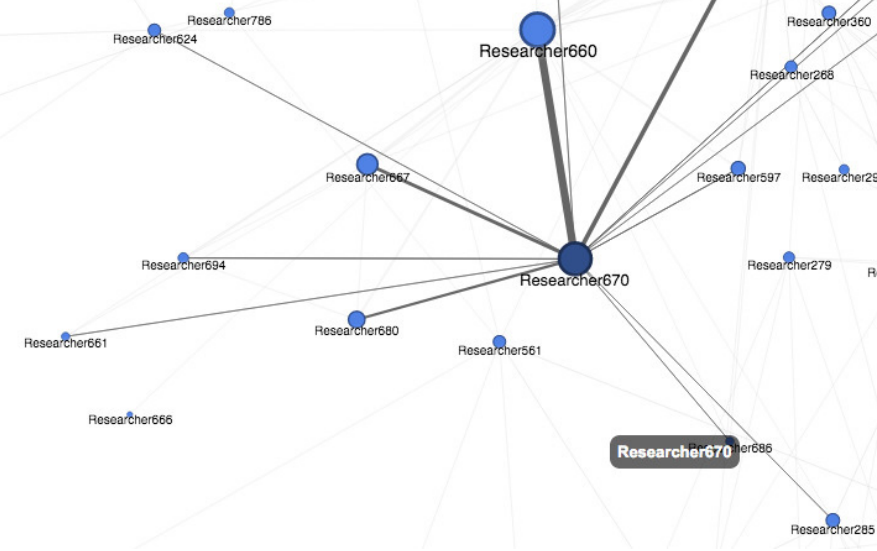
Fig. 3. The researcher with the highest degree of collaboration in